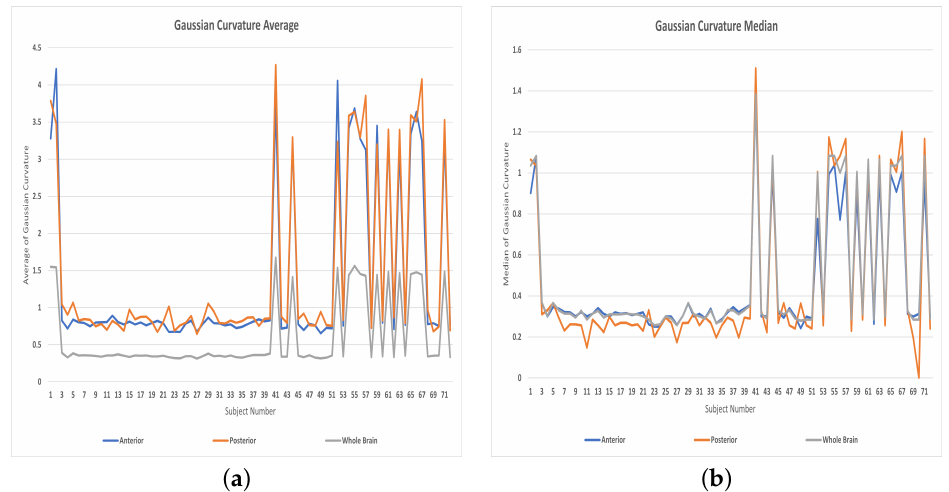
Figure 9. Features distributions: ( a ) Averages of Gaussian curvatures, ( b ) Medians of Gaussian curvatures.